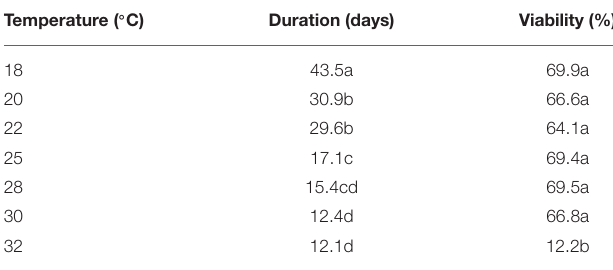
TABLE 3 | Duration and viability of Diaphorina citri life cycle (egg-adult) reared in “Cravo” lemon at different temperatures. Temperature ( ◦